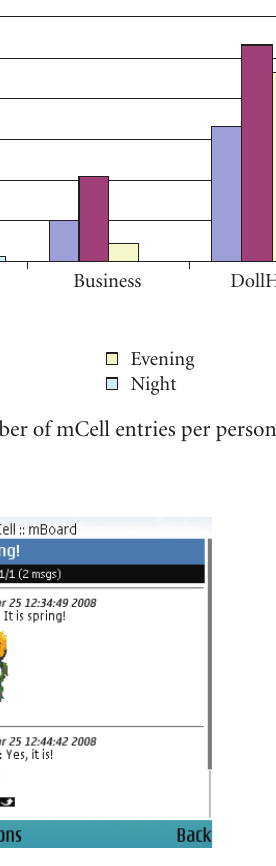
Figure 3: Screenshot of an mBoard conversation